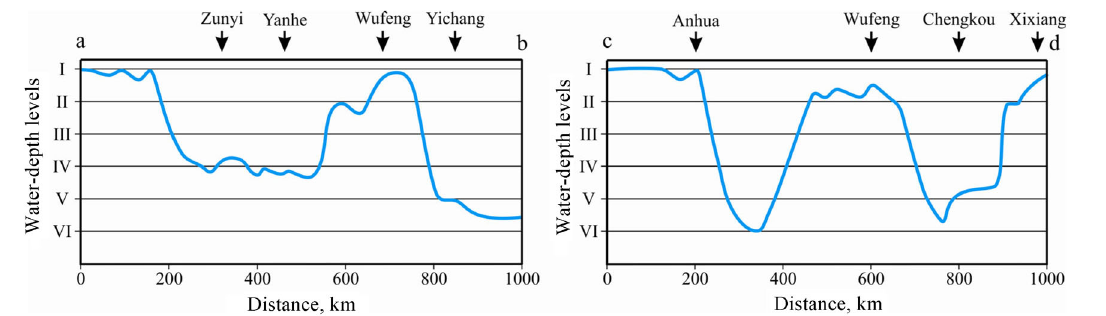
Fig. 4. Topographic profile graphs along two directions (Point a(cid:150)b and Point c(cid:150)d in Fig. 2) created using the line transect method. The arrows indicate the positions of cities. Note that the vertical scale is stretched out to show more details of the topographic